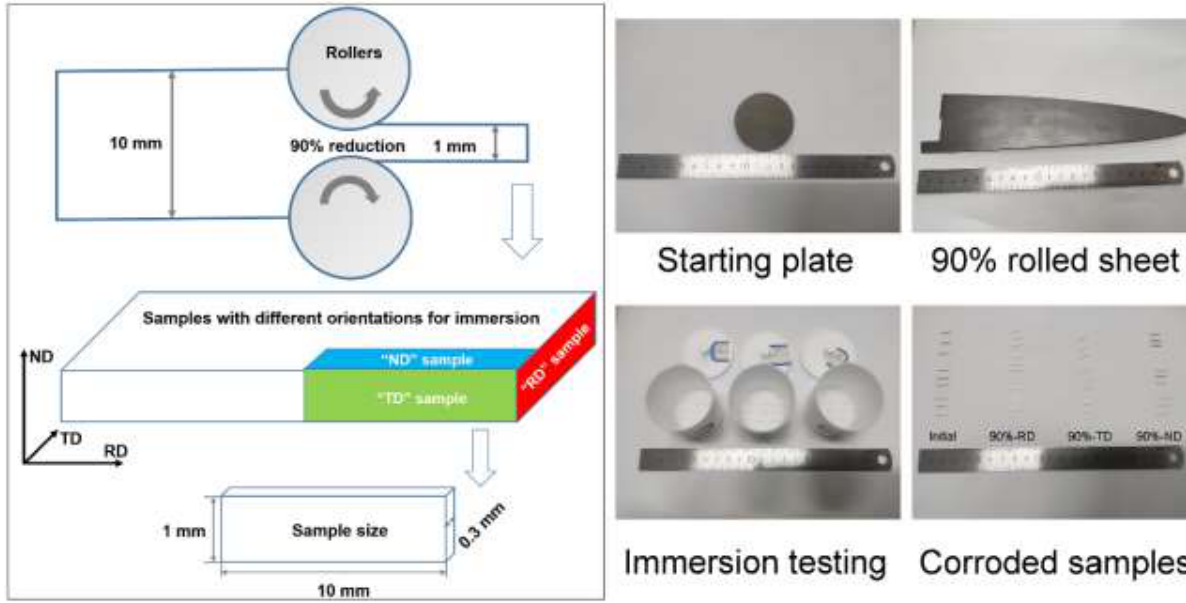
Figure 1. Schematic illustration and experimental pictures of samples for immersion testing: the “initial” sample was cut from the 10 mm-thick plates before cold rolling. The observed surfaces of the “90%-RD”, “90%-TD” and “90%-ND” samples were perpendicular to the rolling direction, transverse direction and normal direction, respectively, of the 90% cold-rolled plate.